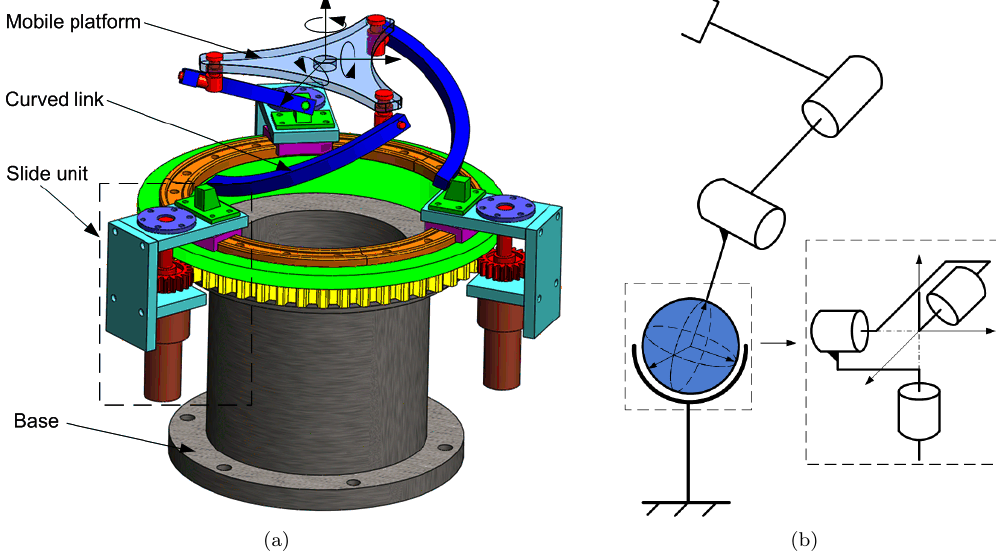
Figure 1: 3-RRR unlimited-roll SPM: (a) CAD model, (b) application as spherically actuated